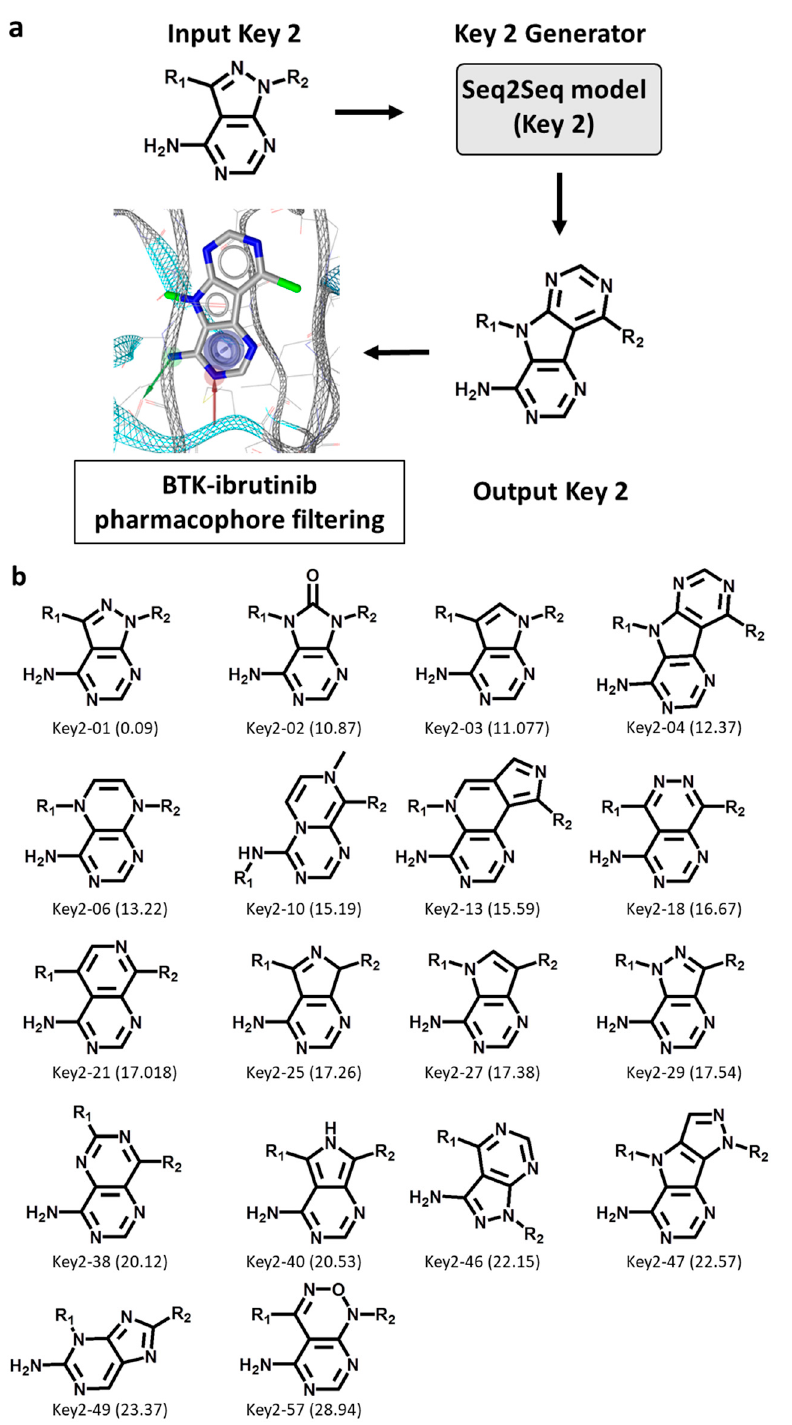
Figure 3. Generation of new Key 2 fragments. ( a ) The computational workflow for generating Key 2 fragments using the Seq2Seq model (Key 2) and pharmacophore filtering. In the lower left image, pharmacophore features including hydrogen bond donor, hydrogen bond acceptor, and aromatic groups are shown as a green arrow, red arrow, and blue circle, respectively. ( b ) The structure of 18 newly generated Key 2 fragments. Below each structure, the identification number and log-likelihood score (in parentheses) are provided.